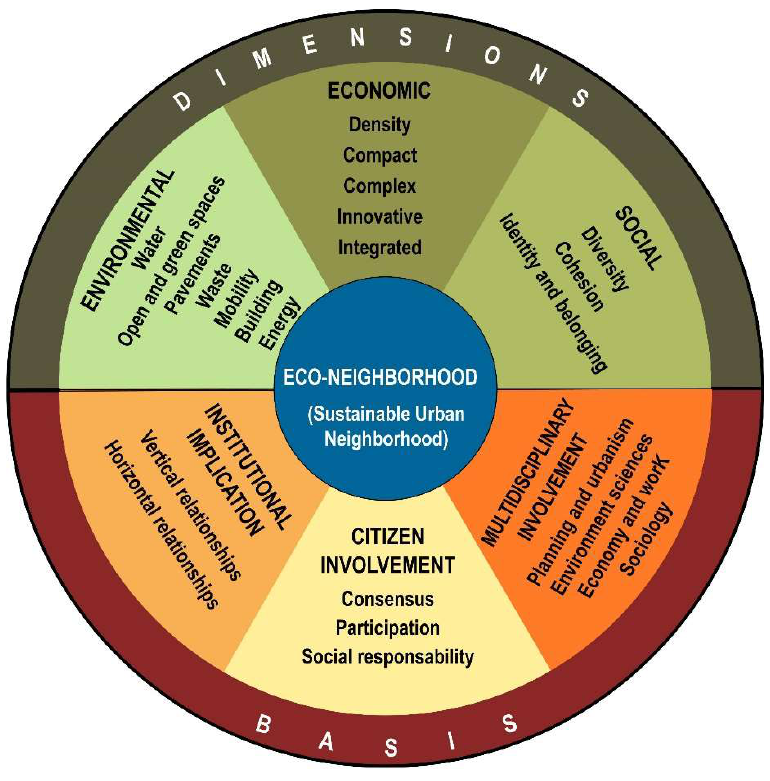
Figure 1. The structure of the eco-neighborhoods. Source: See Appendix A.